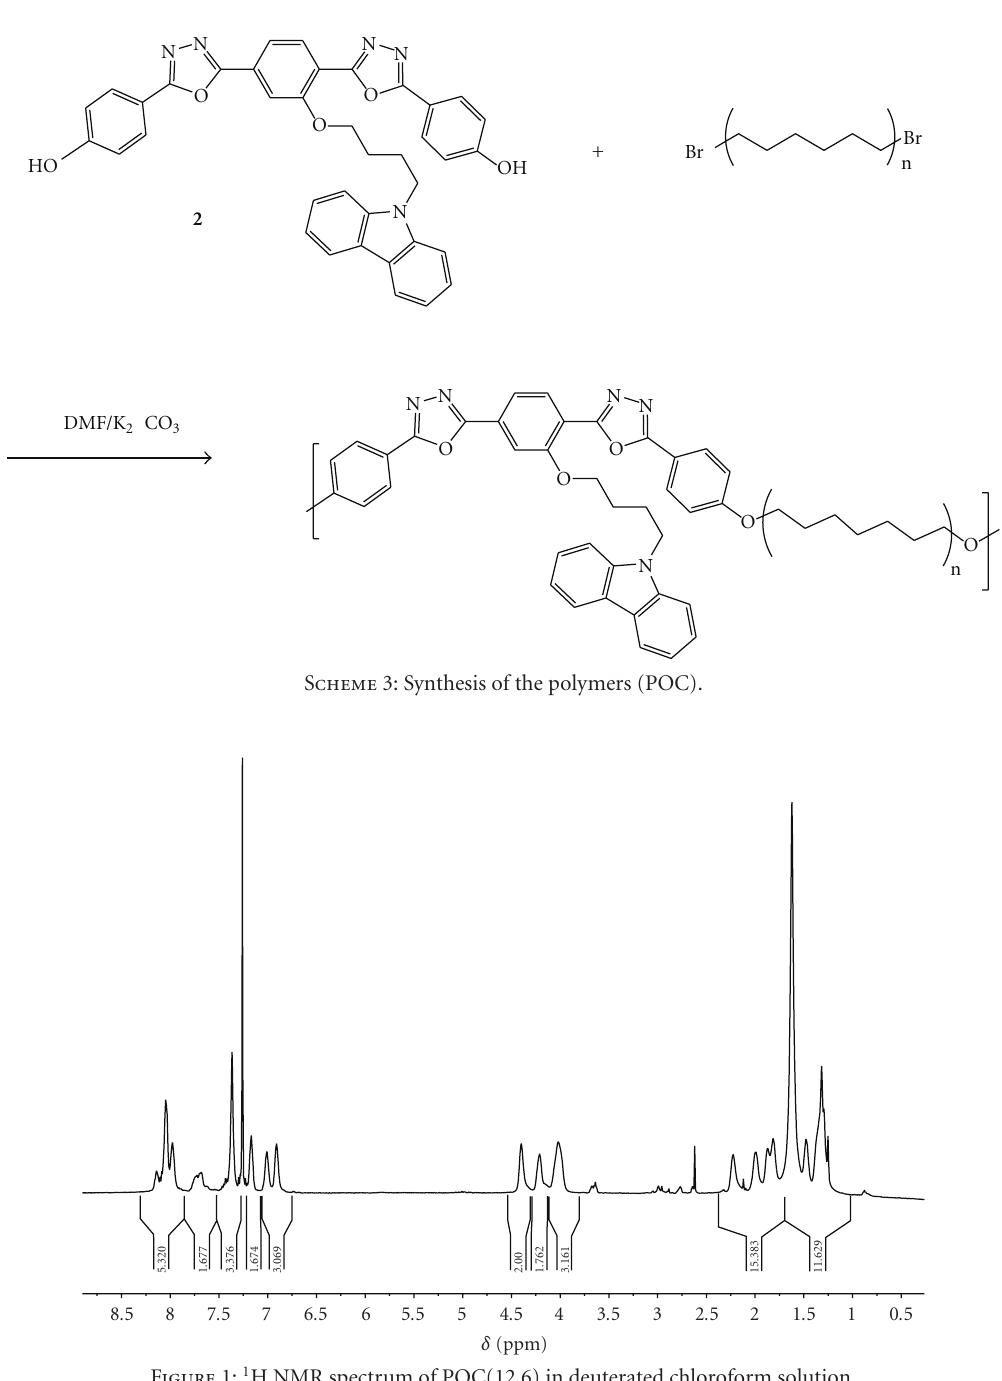
Figure 1: 1 H NMR spectrum of POC(12,6) in deuterated chloroform